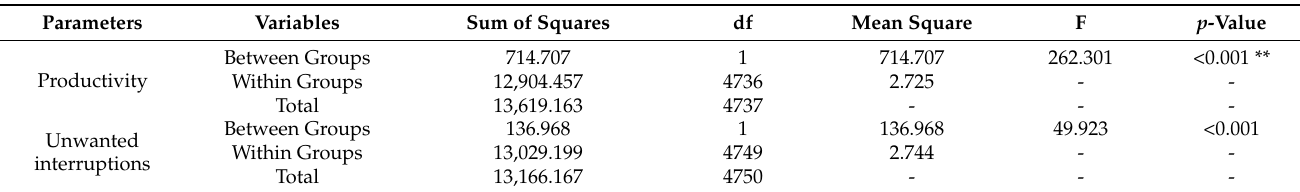
Figure 3. Comparative analysis of mean scores of productivity and unwanted interruptions between sustainable and conventional buildings. Table 8. One-way ANOVA analysis comparing productivity and unwanted interruptions in sustainable and conventional building groups.